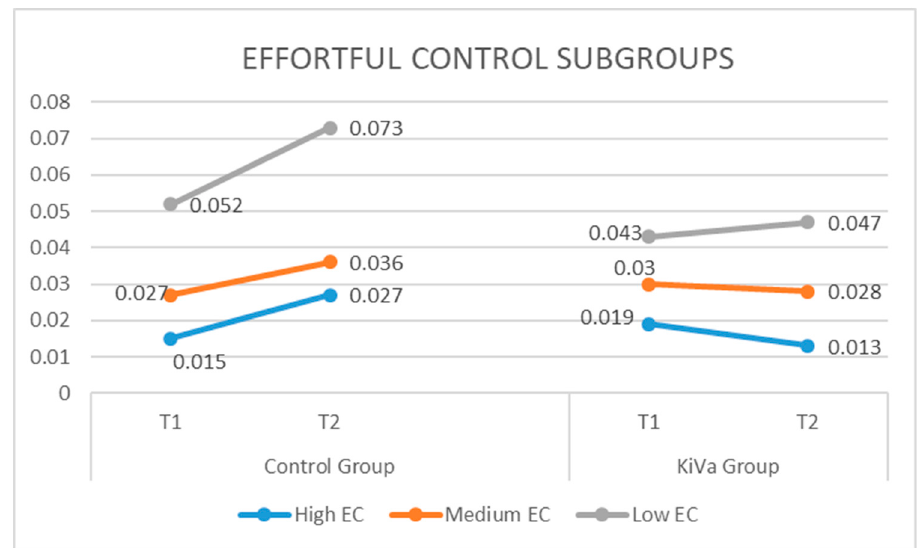
Figure 1. Bullying across time distinguishing between control and KiVa groups, and high, medium, and low levels of effortful control.